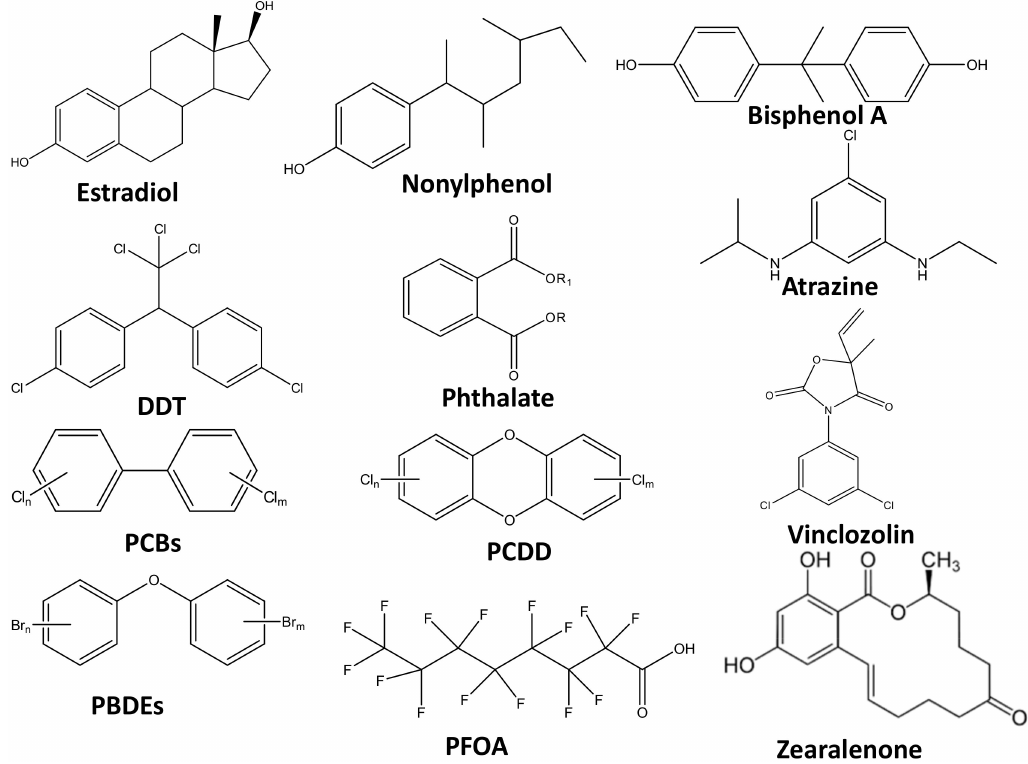
Figure 2. The chemical structures for some endocrine disrupting compounds